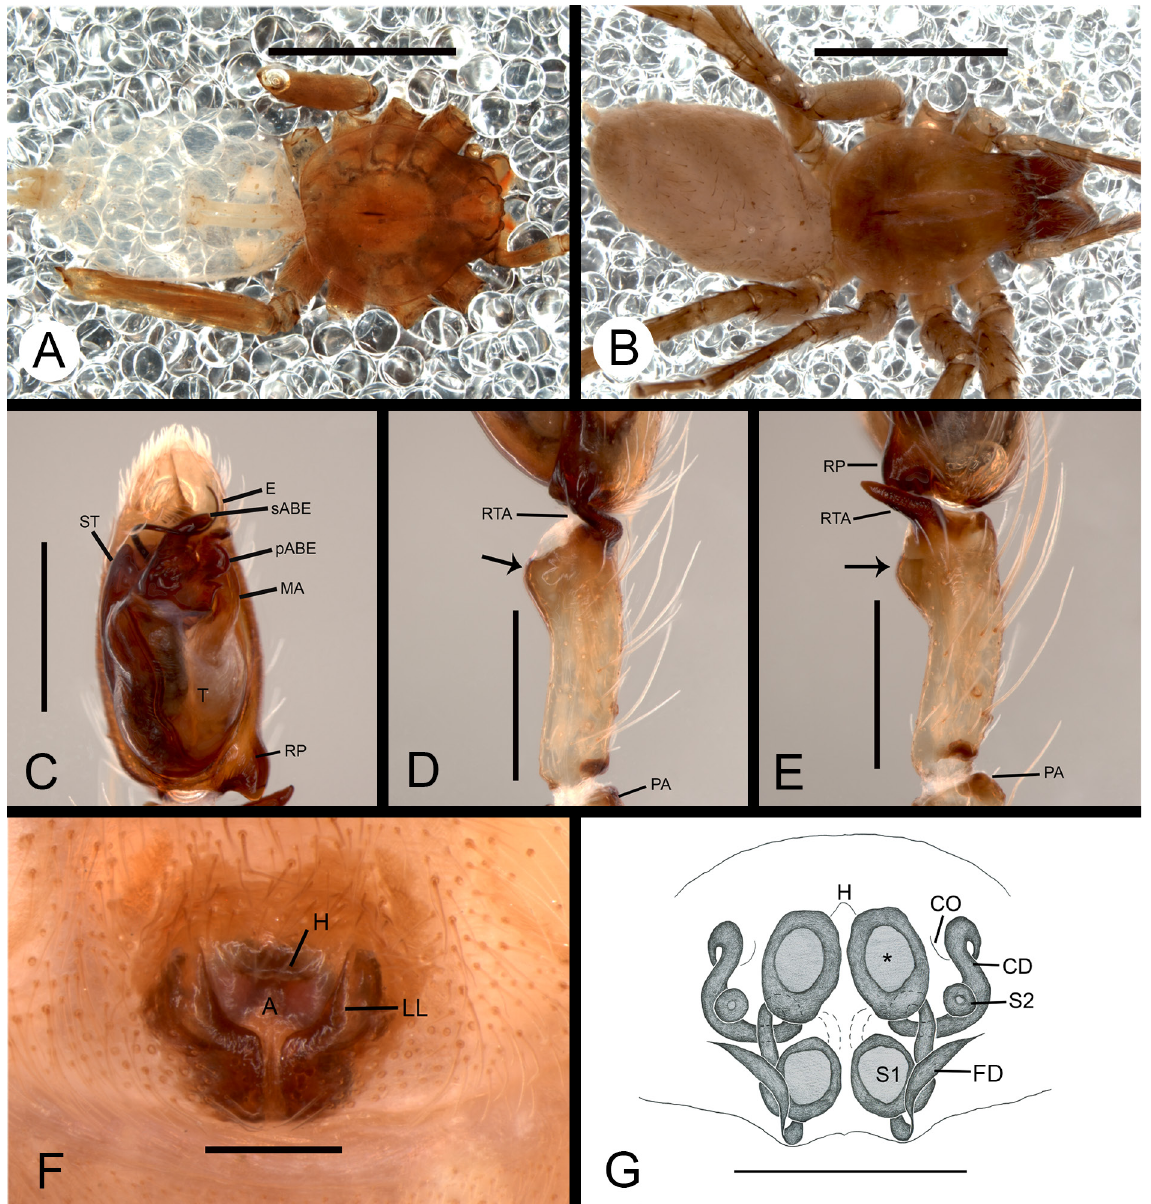
Fig. 16. Tafana pastaza sp. nov. (A, C–E = holotype, ♂, AMNH; B, F–G = paratype, ♀, AMNH). A . Habitus, dorsal view. B . Habitus, dorsal view. C . Left palp, ventral view. D . Left palp, retrolateral view (arrow indicating apical salience). E . Left palp, retrodorsal view (arrow indicating apical salience). F . Epigynum, ventral view. G . Vulva, dorsal view. Abbreviations: A = atrium; CD = copulatory ducts; CO = copulatory opening; E = embolus; FD = fertilization ducts; H = hood; LL = lateral lobes; MA = median apophysis; PA = patellar apophysis; pABE = primary apophysis of base of the embolus; RP = retrolateral projection; RTA = retrolateral tibial apophysis; sABE = secondary apophysis of base of the embolus; S1 = primary spermathecae; S2 = secondary spermathecae; ST = subtegulum, T = tegulum. Asterisks to globose membranous extension of proximal copulatory ducts. Scale bars: A–B = 3.5 mm; C–E = 0.66 mm; F–G = 0.25